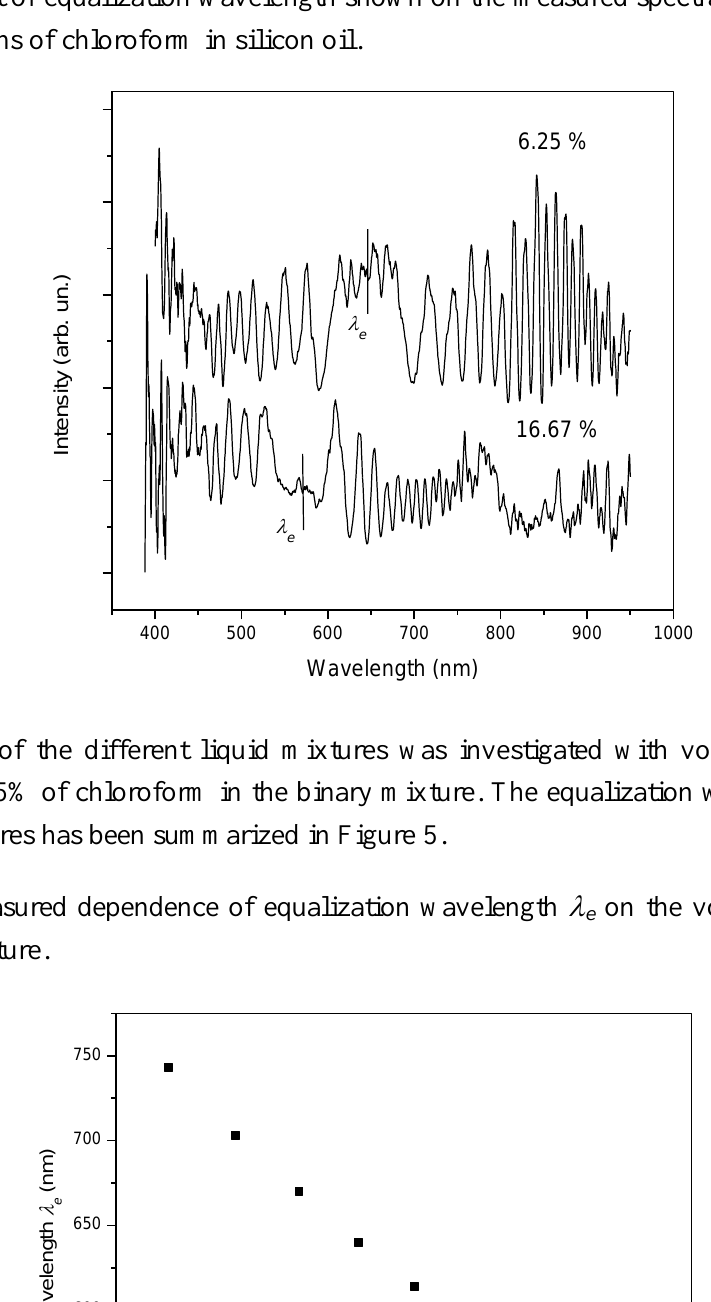
Figure 4. Shift of equalization wavelength shown on the measured spectra for the different volume fractions of chloroform in silicon oil.